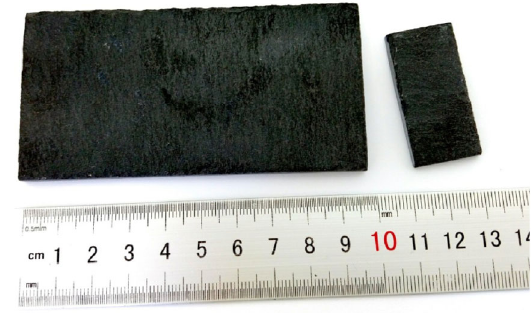
Fig. 2 Shale rock used in this study.